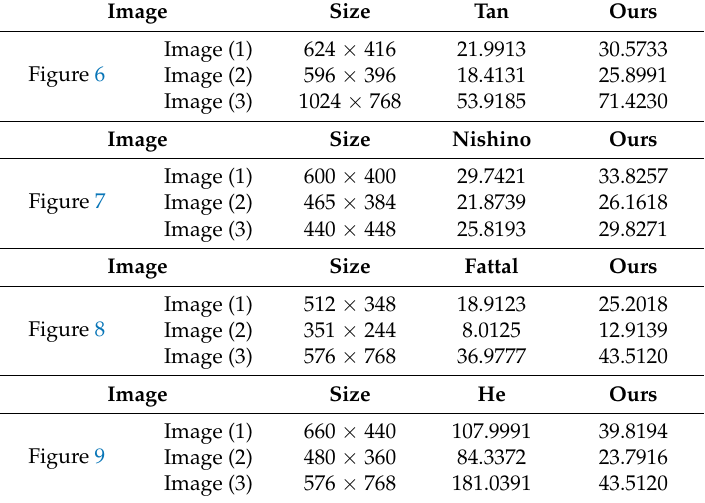
Table 2. Comparisons of arithmetic effectivity on the real-world image for running times (second) of the haze removal